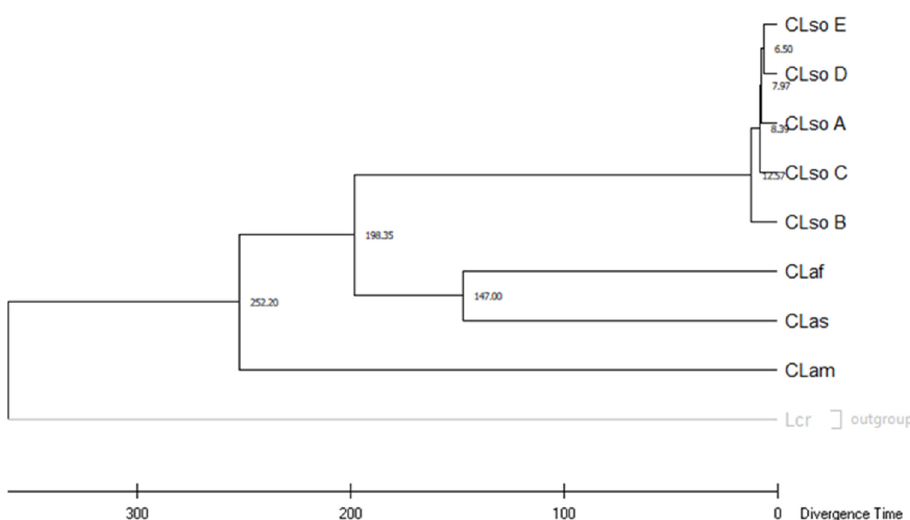
Figure 7. Timetree inferred by applying the RelTime method [31,32] to the user-supplied phylogenetic tree whose branch lengths were calculated using the Maximum Likelihood (ML) method and the Tamura-Nei substitution model [28]. The time tree was computed using one calibration constraint (147 Myr between CLas / CLaf). This analysis involved nine nucleotide sequences and BT1 of L. crescens was used as outgroup. There were a total of 3933 positions in the final dataset. Evolutionary analyses were conducted in MEGA X [27].